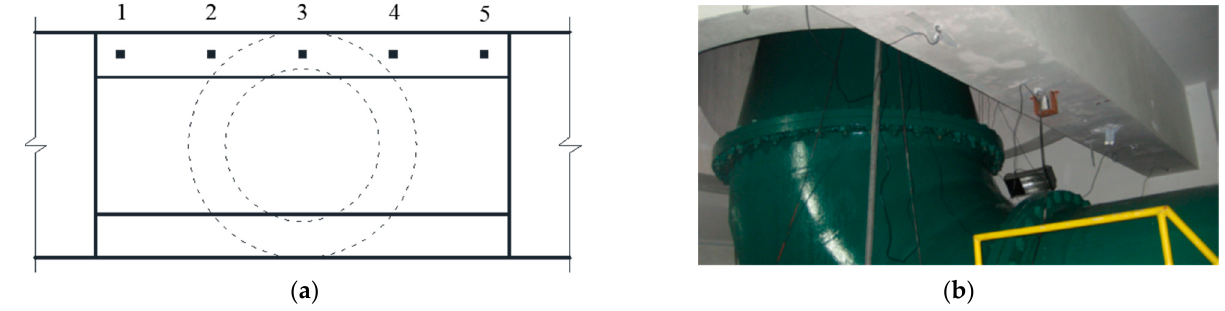
Figure 14. Arrangement of measuring points of the main beam of the pier base. ( a ) Diagram of measuring point arrangement; ( b ) upstream-side main beam acceleration measurement point.